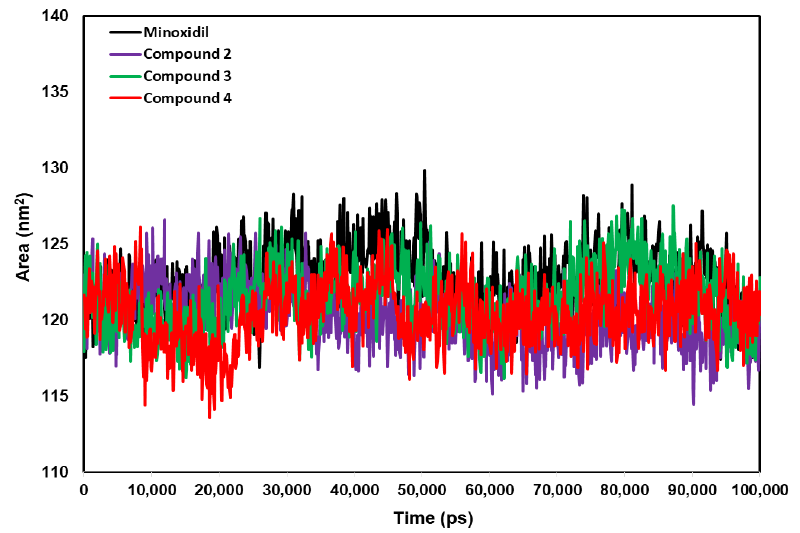
Figure 10. The graph of SASA area for androgen receptor–compound complexes during 100 ns of simulation.